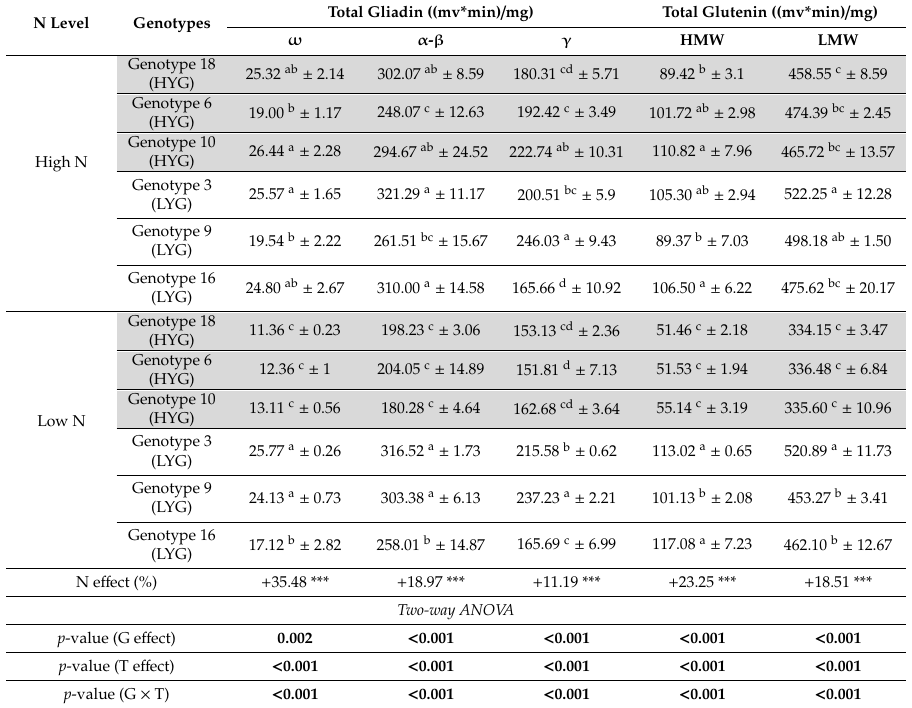
Table 3. Total gliadin and glutenin fractions of 6 wheat genotypes fertilized by two nitrogen levels (High and Low). Means are followed by standard error (n =